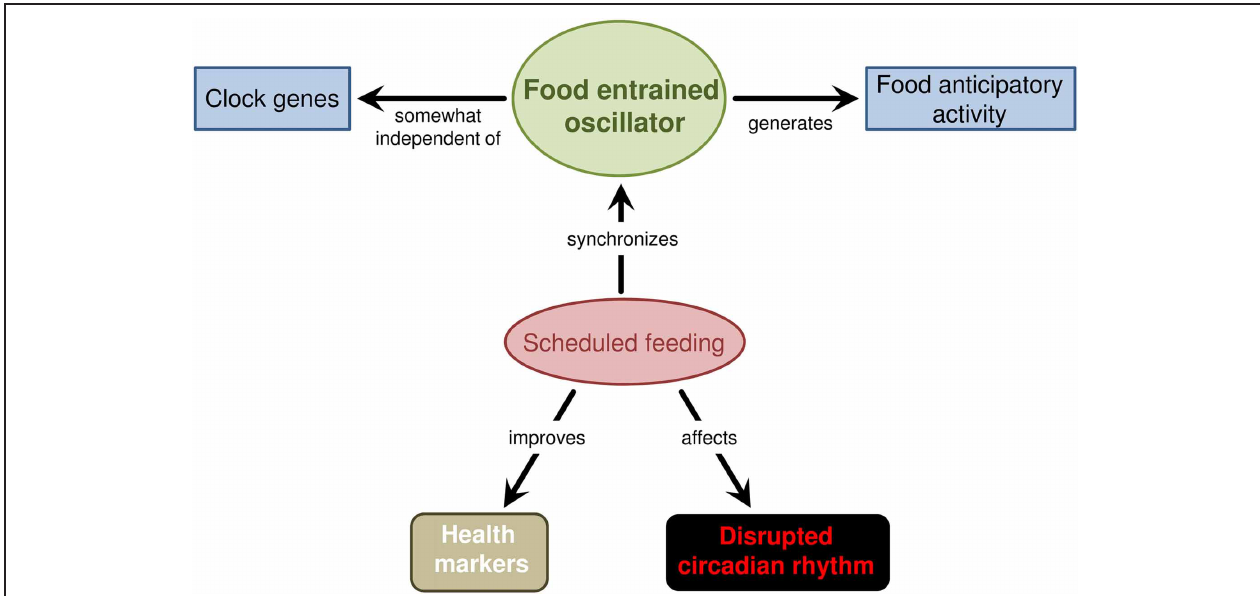
FIGURE 2 | A summarizing scheme on the effect of scheduled feeding in mammals. These animals increase alert and locomotion before feeding time—named food anticipatory activity—when food is available at a specific moment of the day. This behavioral anticipation is generated by a food entrained oscillator that is synchronized by the recurring daily food availability. The anatomical organization of the food entrained oscillator remains elusive but the